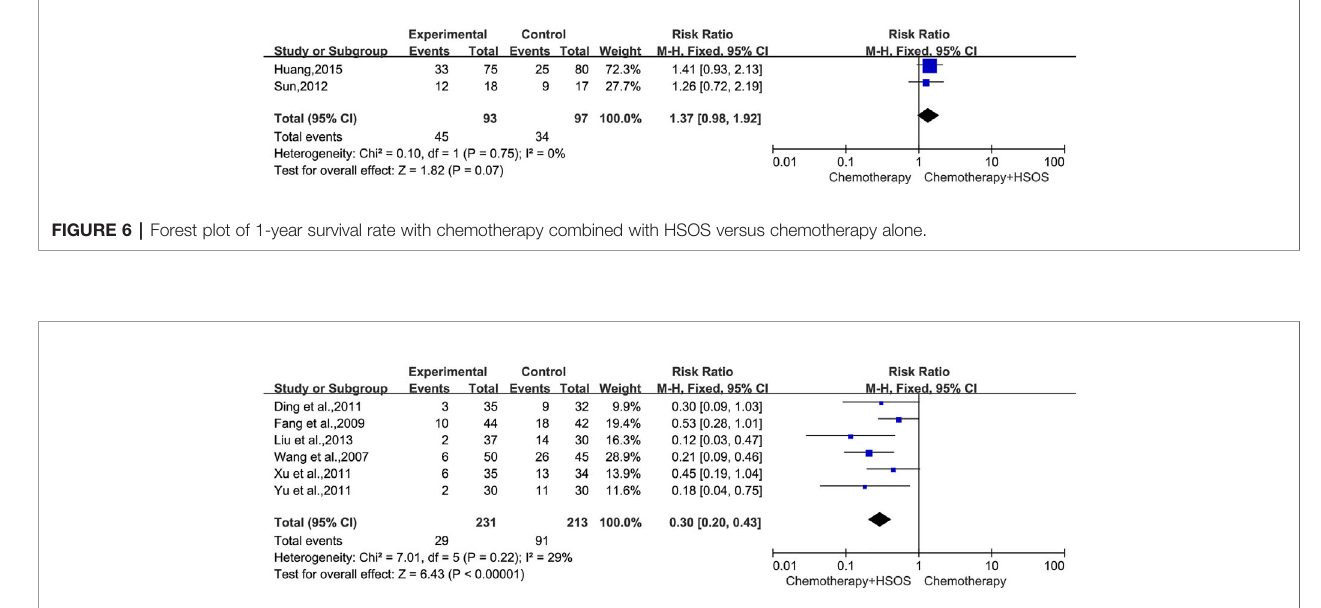
FIGURE 7 | Forest plot of WBC toxicity with chemotherapy combined with HSOS versus chemotherapy